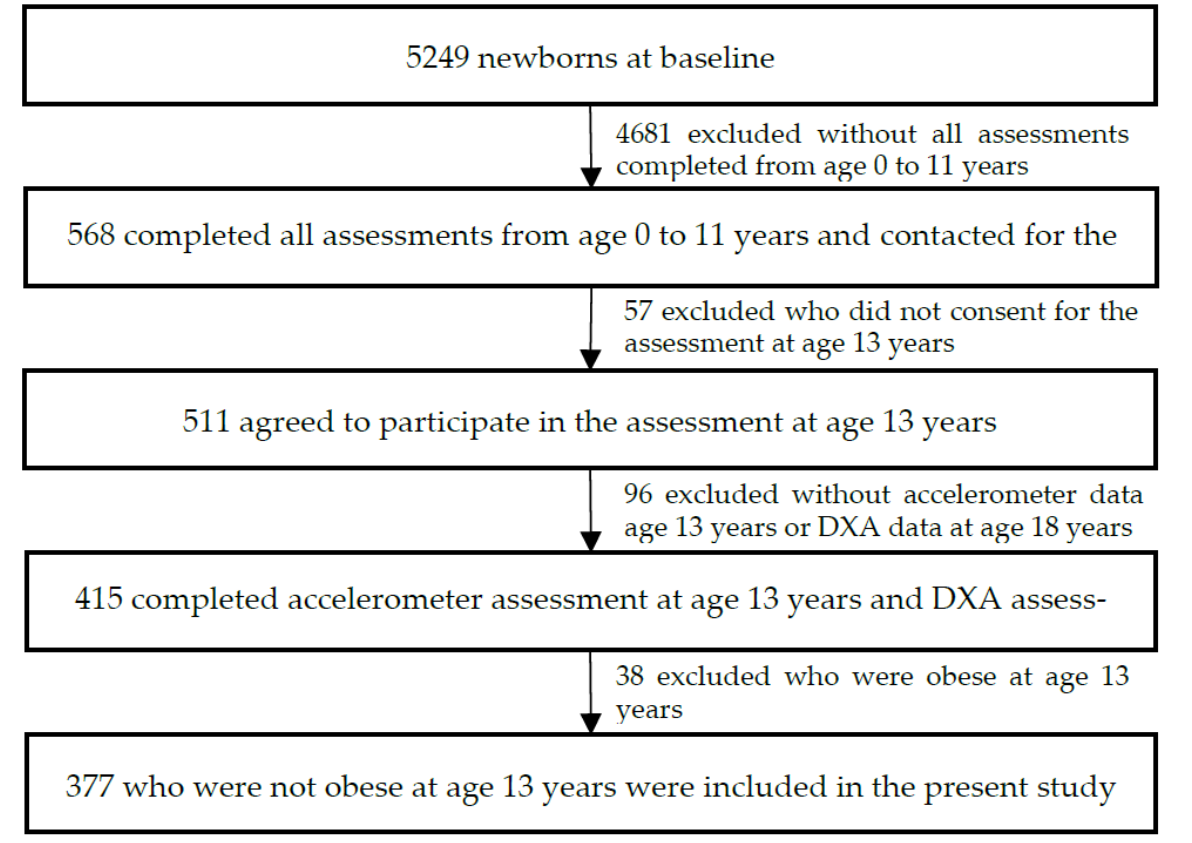
Figure 1. Flow chart depicting the 1993 Pelotas Study participants included in the present study.